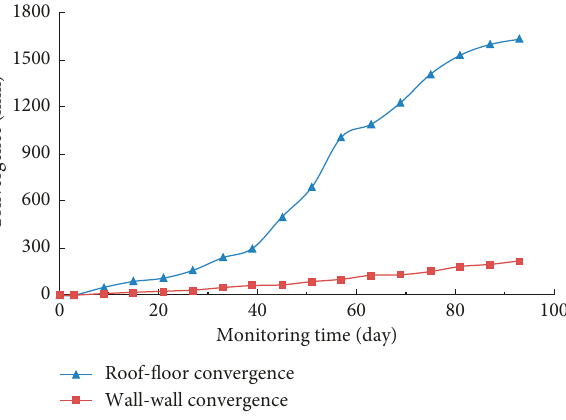
Figure 5: CFC deformation monitoring results.